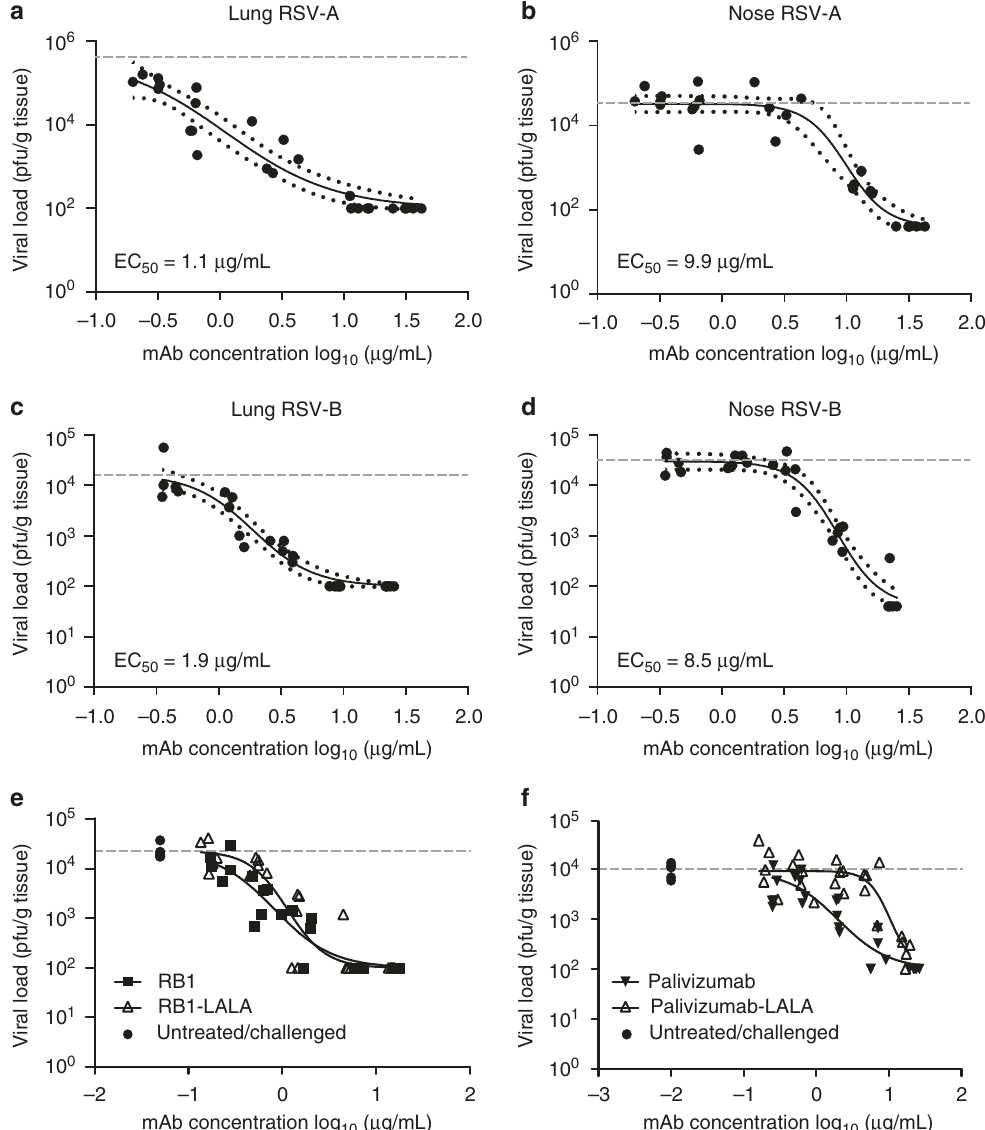
Fig. 4 Ef fi cacy of RB1 in the upper and lower respiratory tracts of cotton rats. Cotton rats were administered RB1 by intramuscular injection with a dose titration and blood was collected for evaluation of serum antibody concentrations the following day. Immediately after blood sample collections, each animal was challenged intra-nasally with 1 × 10 5 plaque-forming units (pfu) of RSV A2 or B 18537 strains. Four days post-challenge, animals were euthanized, blood collected for evaluation of antibody concentrations, and nose and lung tissue collected to assess mAb ef fi cacy by measuring RSV infectious titers in both the nasal and pulmonary tissues. Depicted are the log pfu per gram of tissue for each strain for lung and nose tissues against the log of day 1 serum concentrations in µ g/mL. Points represent observed data (5 animals per dose and 5 untreated per experiment) and lines represent non- linear regression fi t of the inhibitory sigmoidal dose-response analysis with variable slope depicted with 95% con fi dence bands for RSV A lung ( a ), RSV A Nose ( b ), RSV B lung ( c ), and RSV B nose ( d ). e Shows similar analysis after dosing with RB1 or RB1-LALA, which contains mutations to decrease Fc function activity of antibodies, and an analysis of palivizumab as compared to palivizumab-LALA ( f ). The horizontal dotted lines in all graphs represent